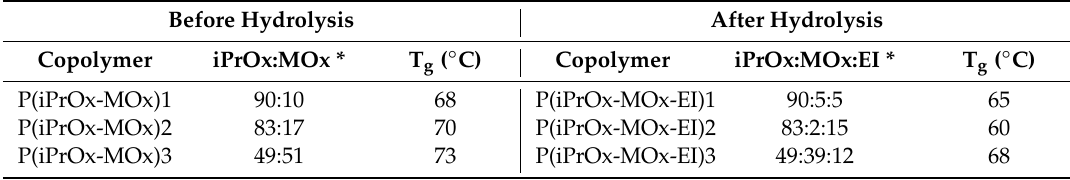
Figure 9. ( a ) DSC traces for iPrOx/MOx/EI copolymers at heating rates of 10 °C/min and ( b ) 2.5 °C/min; ( c ) second DSC heating run (10 °C/min) after quenching of the copolymers. Table 4. T g of copolymers before and after hydrolysis.